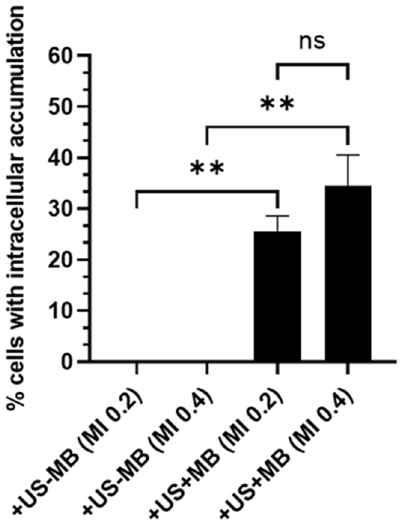
Figure 7. Example of induced intracellular accumulation in cells lining blood vessels in the choroid after treatment with USMB at MI 0.4. Yellow asterisks in the overlay image indicate the lumen of choroidal blood vessels. White dotted line indicates the area of cells lining the blood vessel lumen. Overlay image is a combination of fluorescent and phase contrast images. Green is indicated by the “SYTOX Green name”. TRITC and DAPI are widely used fluorophores with red and blue colors, respectively. Scale bar: 10 μ m.